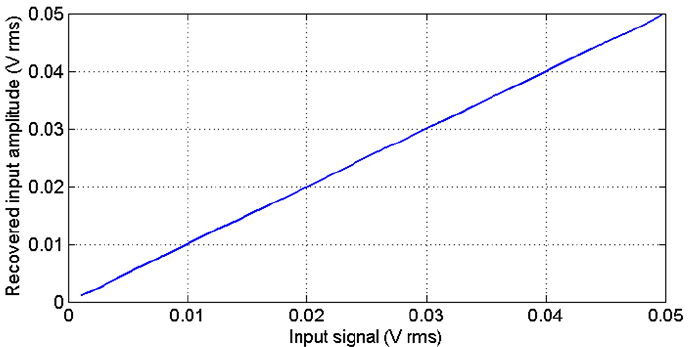
Figure 8. LIA experimental recovered input amplitude vs. input signal with different amplitude values for a 500 kHz square